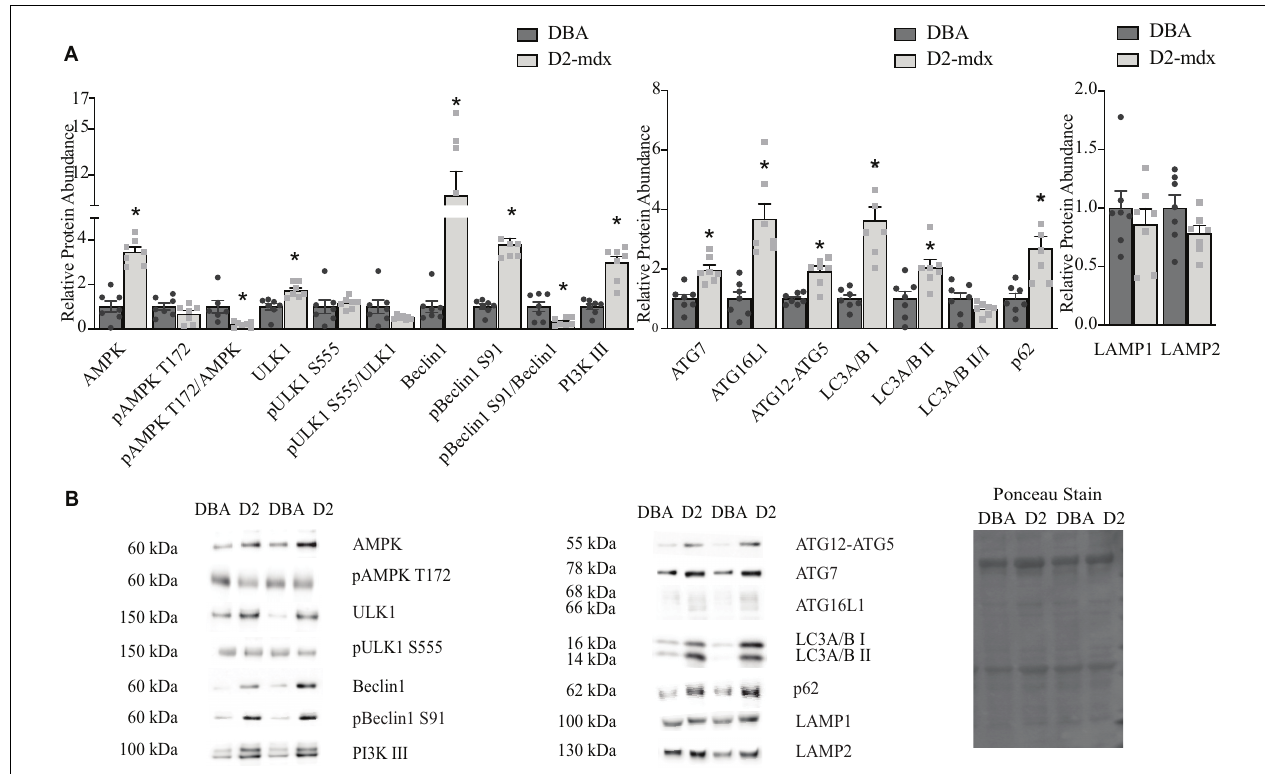
FIGURE 1 | Markers of autophagy are altered in dystrophin deficient diaphragms. Western blot analysis of markers of autophagy in whole muscle extract from 11 month old DBA and D2-mdx diaphragms. (A) Among the activation markers, AMPK, ULK1, Beclin1, pBeclin1 S91, PI3K III were increased in D2-mdx diaphragm compared to DBA. In muscle from D2-mdx mice, the ratios pAMPK T172/AMPK and pBeclin1 S91/Beclin1 were decreased compared to muscle from DBA. The autophagosome formation markers ATG7, ATG16L1, ATG12-ATG5 were increased significantly in muscle from D2-mdx mice compared to DBA. Accumulation of autophagosomes was indicated by higher abundance of LC3 II and p62 in D2-mdx muscles compared to muscles from DBA mice. Lysosomal markers LAMP1 and LAMP2 were similar between groups. (B) Representative western blot images and corresponding representative Ponceau stain image used to confirm equal loading. Significance is established at p < 0.05. * Indicates significance between D2-mdx and DBA ( n = 7 mice per group).